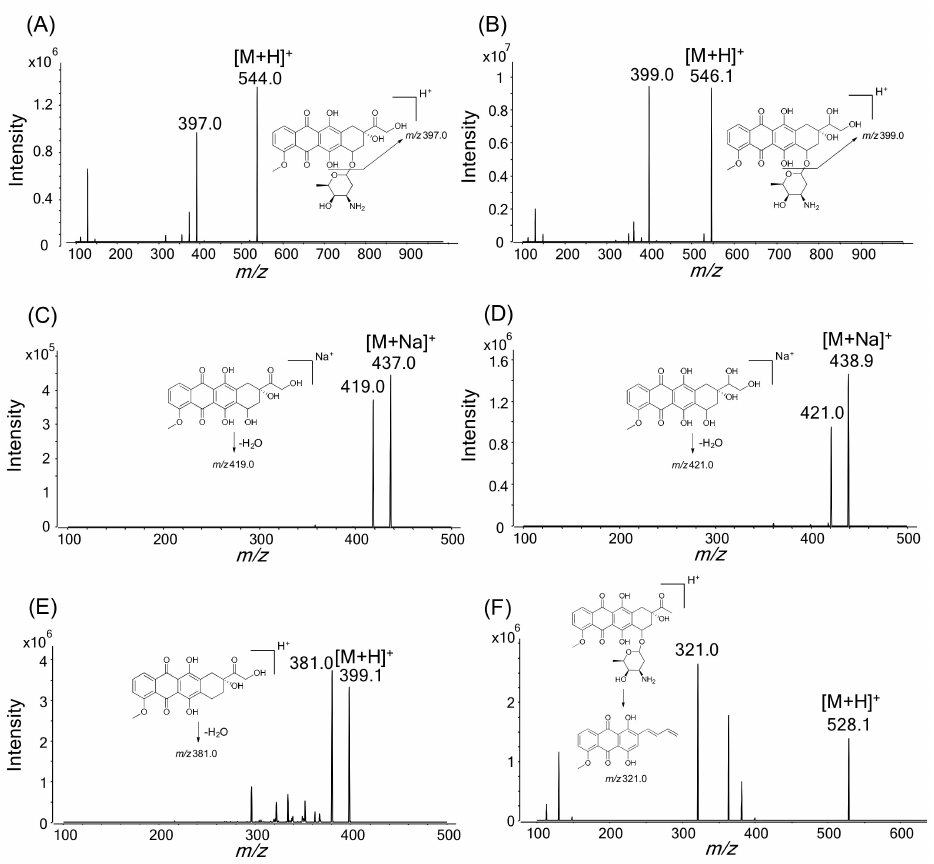
Figure 2. Product ion spectra of ( A ) doxorubicin, (B ) doxorubicinol, ( C ) doxorubicinone, ( D ) doxorubicinolone, ( E ) 7-deoxydoxorubicinone, and ( F ) daunorubicin (internal